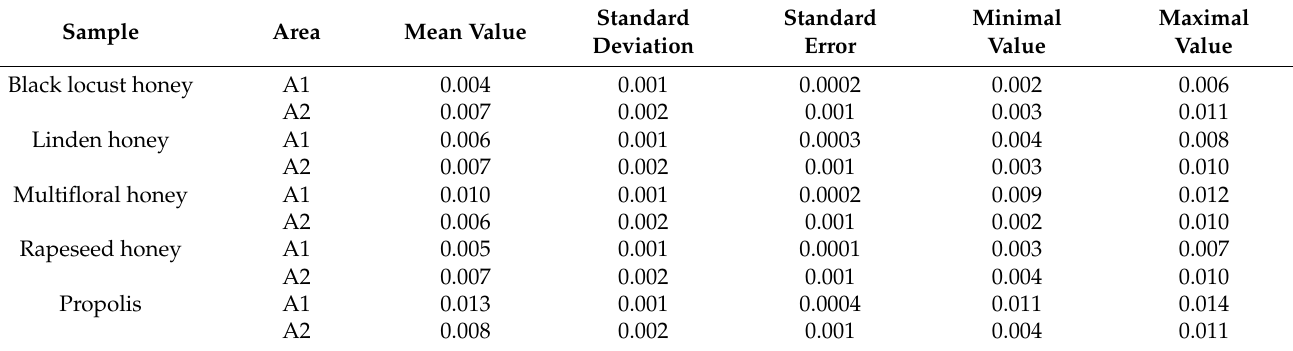
Table 10. Bioconcentration factor for Pb.